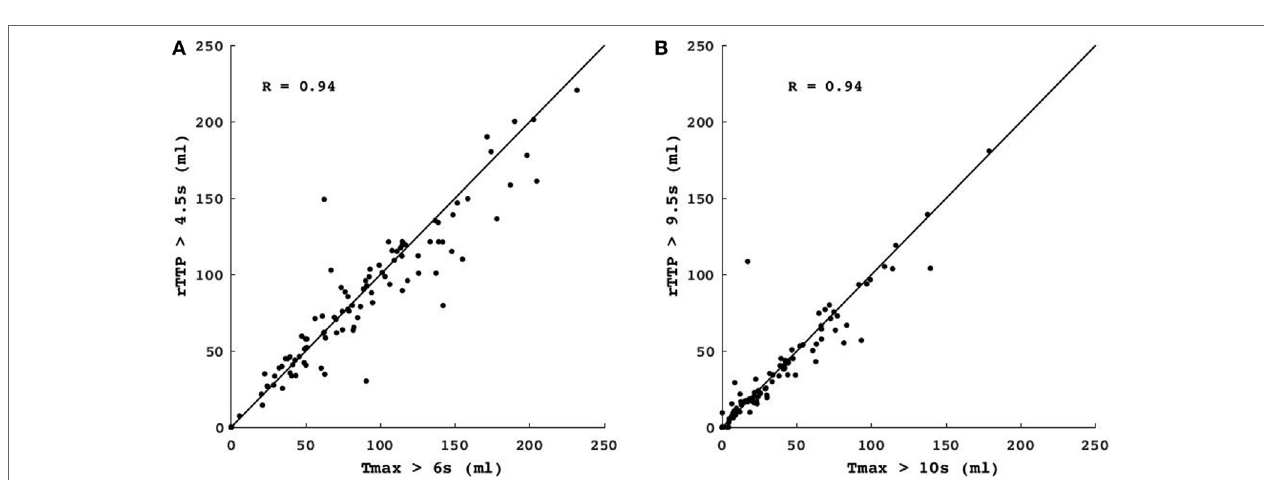
FigUre 3 | Comparison of Tmax vs. relative TTP (rTTP) lesion volumes. The scatterplots show the correlation between the volume of critical hypoperfusion assessed with a Tmax > 6 s vs. an rTTP > 4.5 s threshold (a) and the volume of severe hypoperfusion assessed with a Tmax > 10 s threshold vs. an rTTP > 9.5 s threshold (B) . Identity lines are depicted for both graphs. R = Pearson’s correlation coefficient.